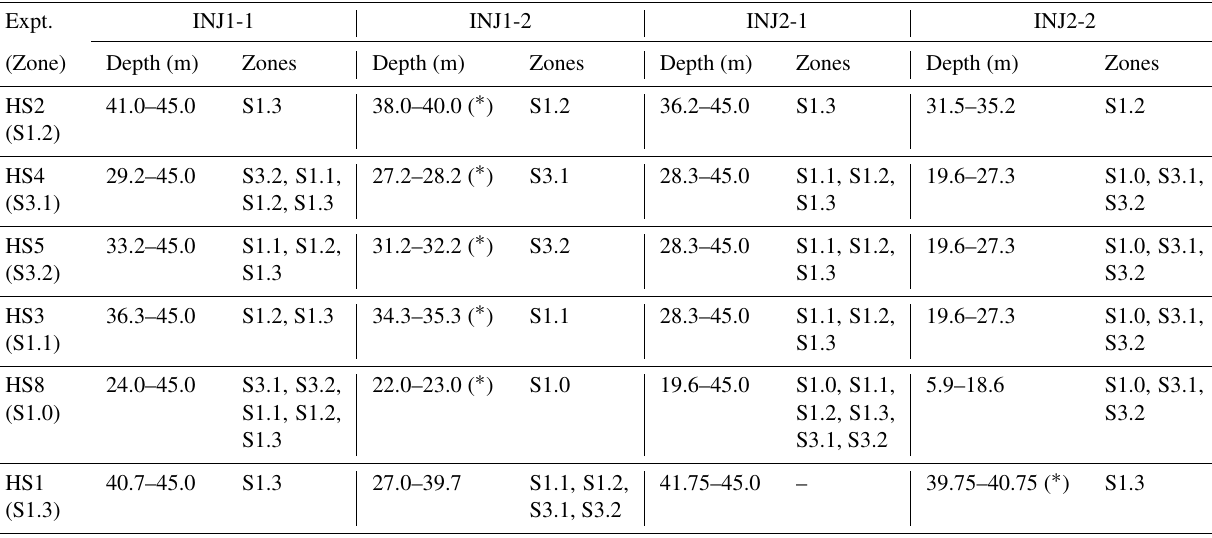
Table A1. Locations and packed-off length of monitoring intervals in the INJ boreholes during the stimulation experiments. The fracture zones that intersect the interval are given in the adjacent column. Monitoring intervals that include the interval undergoing injection in the other INJ borehole are marked with ( ∗ ).